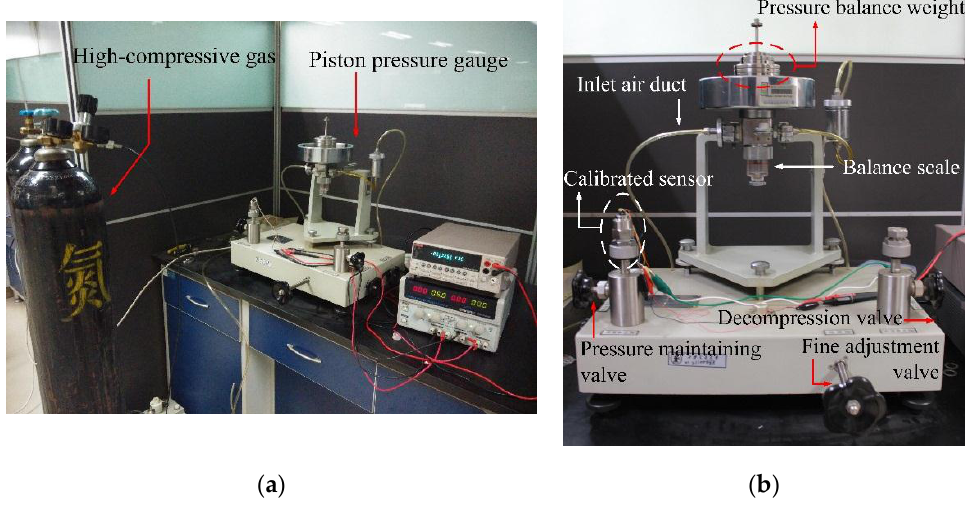
Figure 24. Experiment facilities for the anti-overload test: ( a ) the photo of whole set; ( b ) piston pressure gauge.